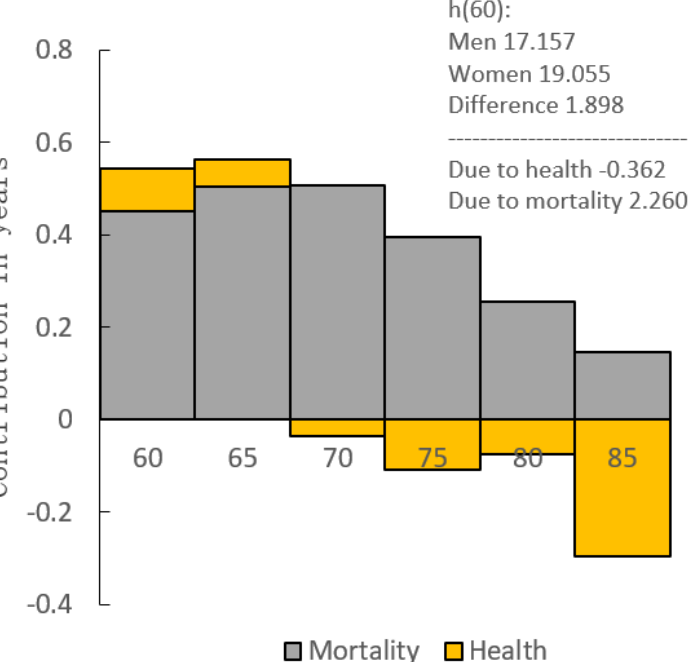
Figure 1. Decomposition of the difference between the DFLE of elderly in Jiangxi Province at age 60 between men and women.